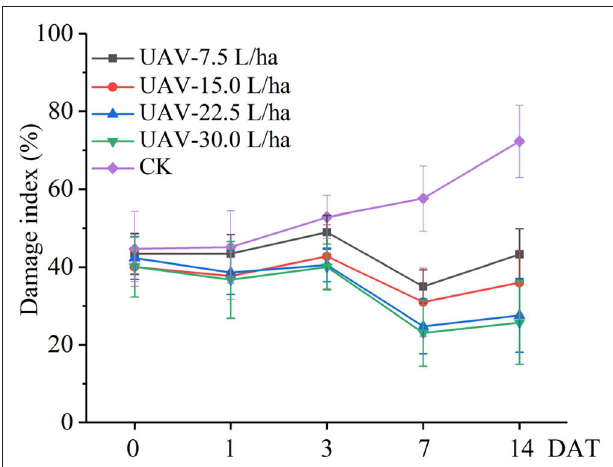
FIGURE 8 | The damage index changed with the application